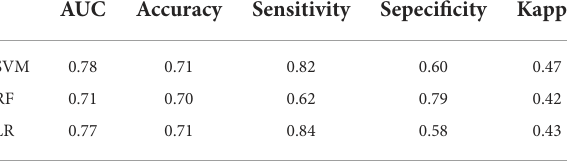
TABLE 3 Classification performance of machine